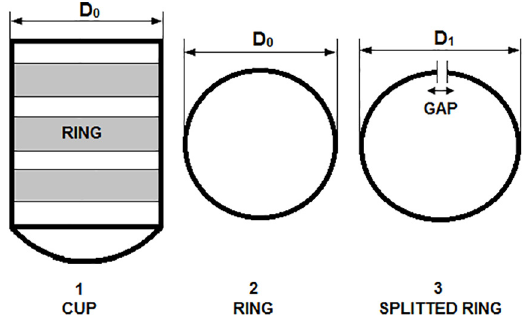
Figure 4. Schematically showing of split ring test schedules.